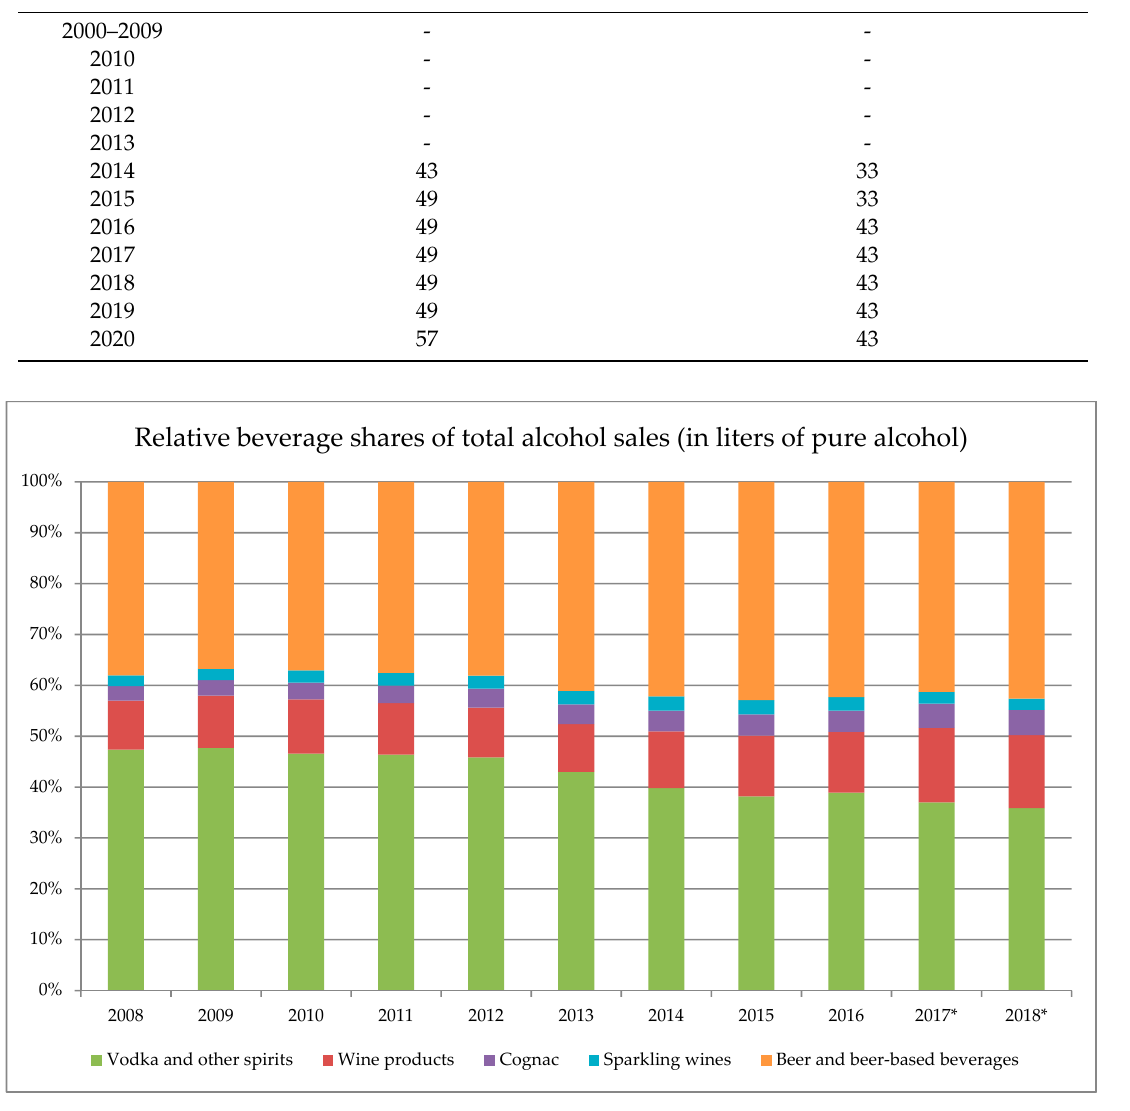
Figure A1. Relative shares of alcoholic beverages in total sales, converted into pure liters of alcohol of each beverage type (for details, see methodological descriptions above). Sources: Federal State Statistics Serves, beginning in 2017, Federal Service for Alcohol Market Regulation as based on EGAIS * monitoring. Table A6. Overview of most important law changes addressing unrecorded alcohol since 2009. Source: Consultant.ru. * Government Decree No. 775 “On Excise Stamps for the Marking of Alcohol Products” establishes new safety requirements for excise stamps 2012